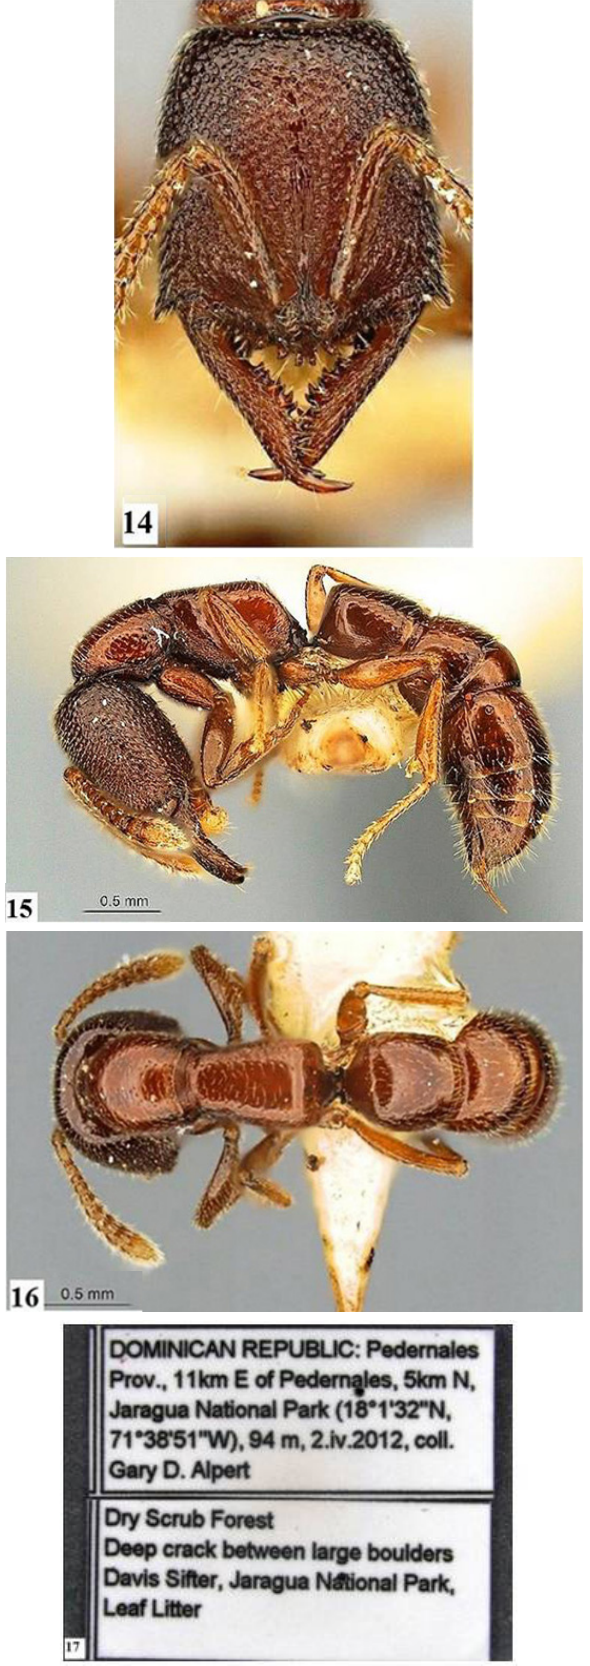
Fig 14-17. Stigmatomma falcatum (worker-image from antwiki): 14 . Head in full face-veiw; 15. Body in profile veiw; 16. Body in dorsal veiw; 17. 17. Label of Stigmatomma